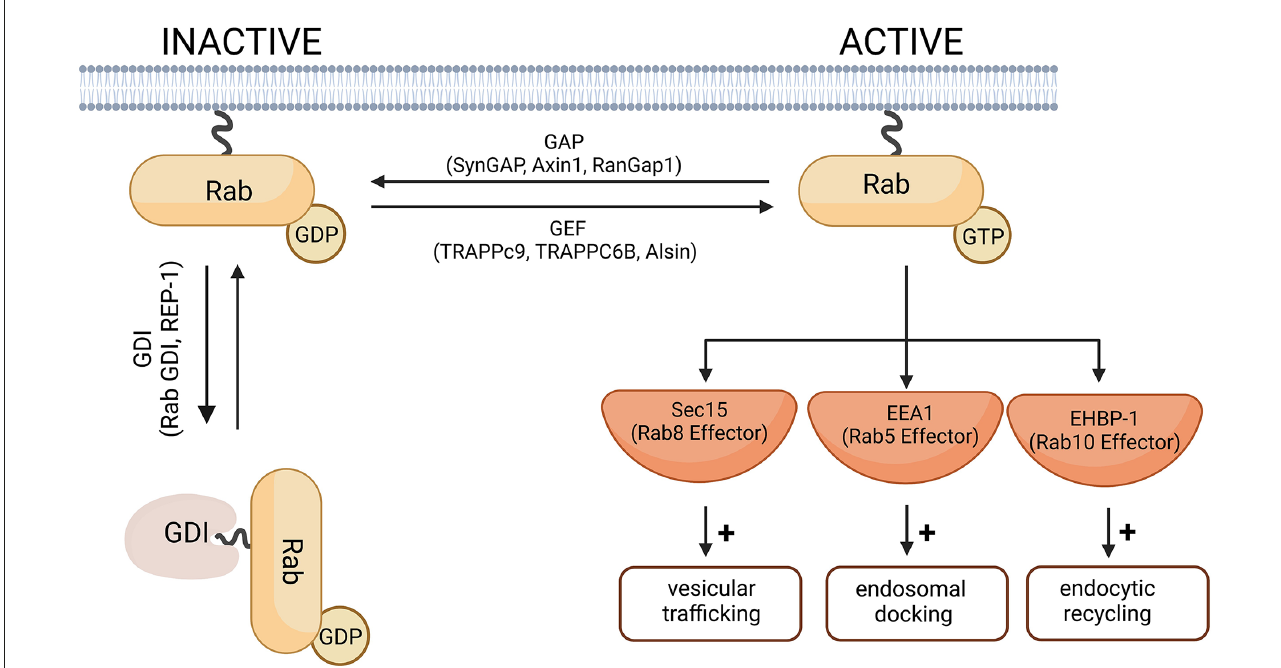
FIGURE2 A schematic diagram of the Rab-GTPase activation and inactivation. In their inactive forms, Rab-GTPases are GDP-bound. The switch from GDP to GTP is mediated by Rab-GEF proteins and leads to Rab activation. Rab-GAP proteins hydrolyze the Rab-bound GTP to GDP and thus the Rab-GTPase returns to its inactive form. Cytosolic GDI proteins prevent the exchange of GDP for GTP and therefore keep the Rab protein in its inactive form. Representative Rab-GEF and Rab-GAP proteins linked to neurodegenerative disorders are given as examples and are further discussed in this review. Examples of effector proteins and the cellular responses they mediate include Sec 15 that mediates Rab8-dependent modulation of vesicular trafficking (Feng et al., 2012); EEA1, downstream of Rab5-dependent endosomal docking (Christoforidis et al., 1999), and EHBP-1 dowstream of Rab10-dependent endocytic recycling (Shi et al., 2010). Created with